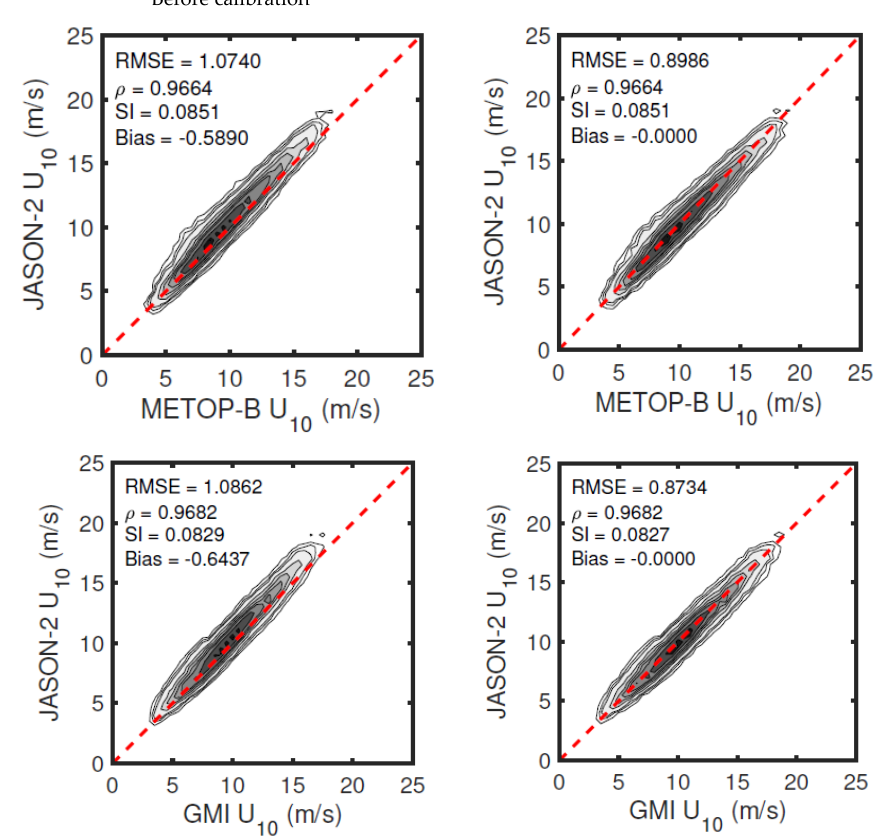
Figure 7. Comparisons of selected cases of matchup data before and after triple collocation calibrations were applied. The contours represent the normalized density of data points, with contours drawn at 0.9, 0.7, 0.5, …, 0.1, 0.07, 0.04 (maximum value is one).